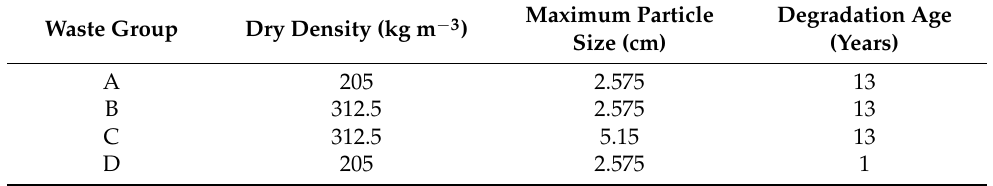
Table 2. Test scheme for inversion of hydraulic characteristics of waste with different